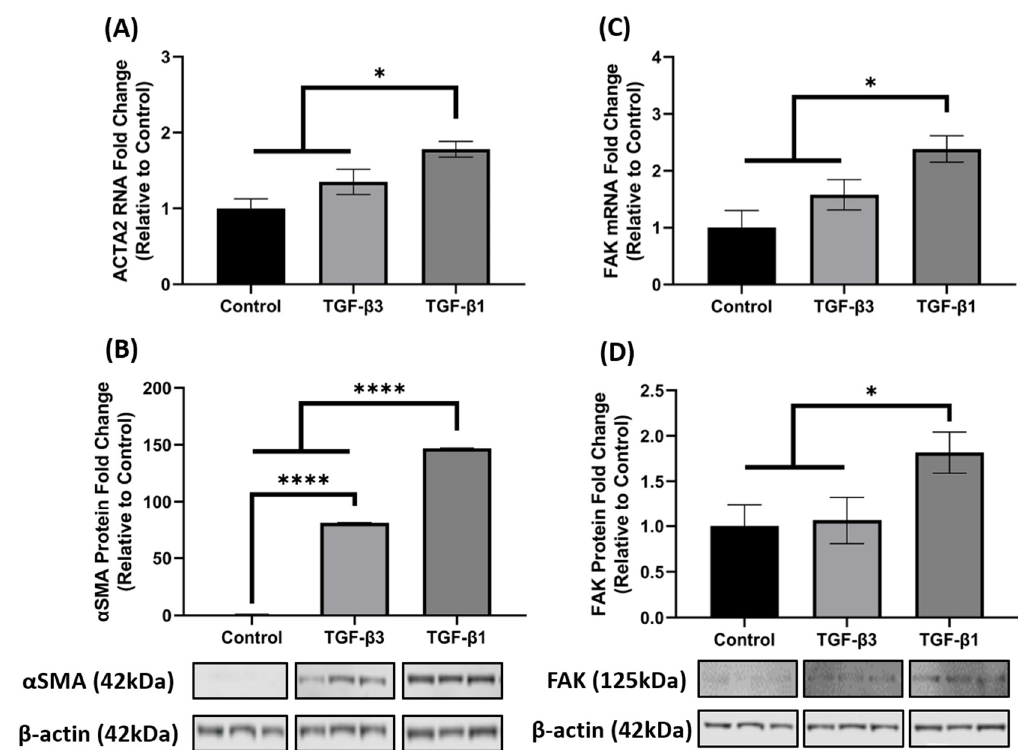
Figure 2. TGF- β 1 treatment induced ACTA2/ α SMA and FAK expression in hCF 3D constructs. Characterization of ACTA2/ α SMA and FAK expression in 4-week human corneal fibroblast (hCF) 3D constructs. mRNA and protein were isolated from 4-week hCF constructs that were either untreated (control) or treated continuously with TGF- β 1 or TGF- β 3. ( A , C ) Extracted mRNA from constructs per experimental condition was examined by qRT-PCR analysis for ACTA2 and FAK . ( B , D ) Cell lysates were prepared from constructs and analyzed for relevant target proteins ( α SMA and FAK) and β -Actin (loading control). Bands were measured by densitometry analysis, and average fold change of targeted proteins are shown relative to control ± SEM; n = 3 per group. * p < 0.05, **** p < 0.0001. ACTA2, Alpha smooth muscle actin; FAK, Focal Adhesion Kinase.